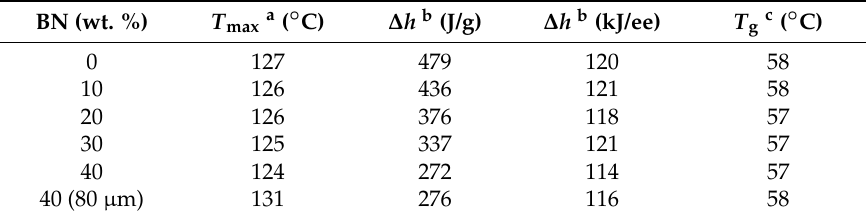
Table 1. Calorimetric data of formulations ECC/PETMP with several proportions of